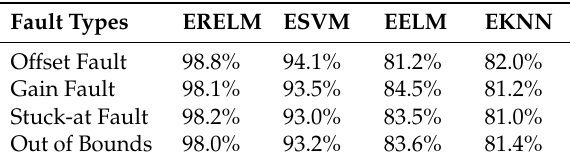
Table 4. DA with 20% induced faults.